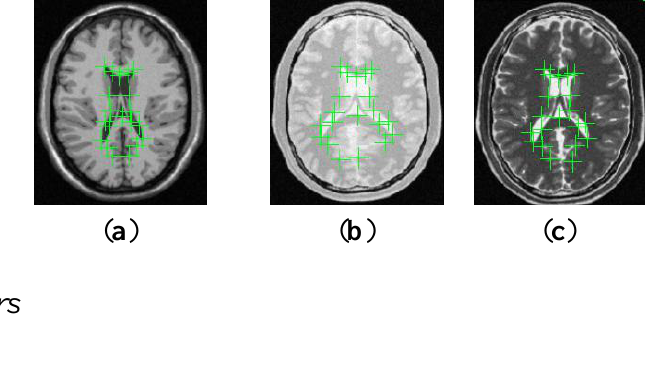
Figure 6. Landmarks in the deformed T1, deformed PD and original T2 images. ( a ) Landmarks in the Deformed T1; ( b ) Landmarks in the Deformed PD; ( c ) Landmarks in the original T2.